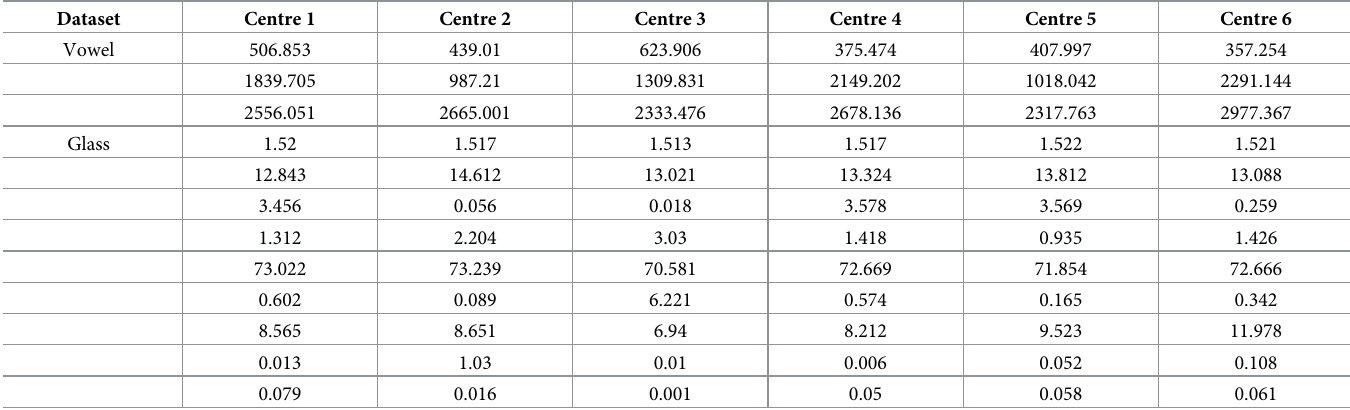
Table 8. The best clusters centres on the Vowel and Glass datasets obtained by the AMADE algorithm. Dataset